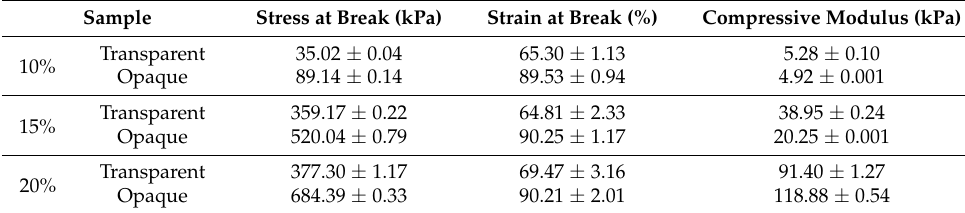
Figure 5. Mechanical properties of transparent and opaque gels. ( a ) Demonstrative images of the shape recovery for hydrogels and cryogels. Characteristic stress-strain profiles attained by uniaxial compression (Insets demonstrate the straight line for tensile modulus measurement below 30% strain) ( b ) 10%, ( c ) 15%, and ( d ) 20% gels (n = 3). Table 1. Mechanical properties of BSAMA hydrogels and